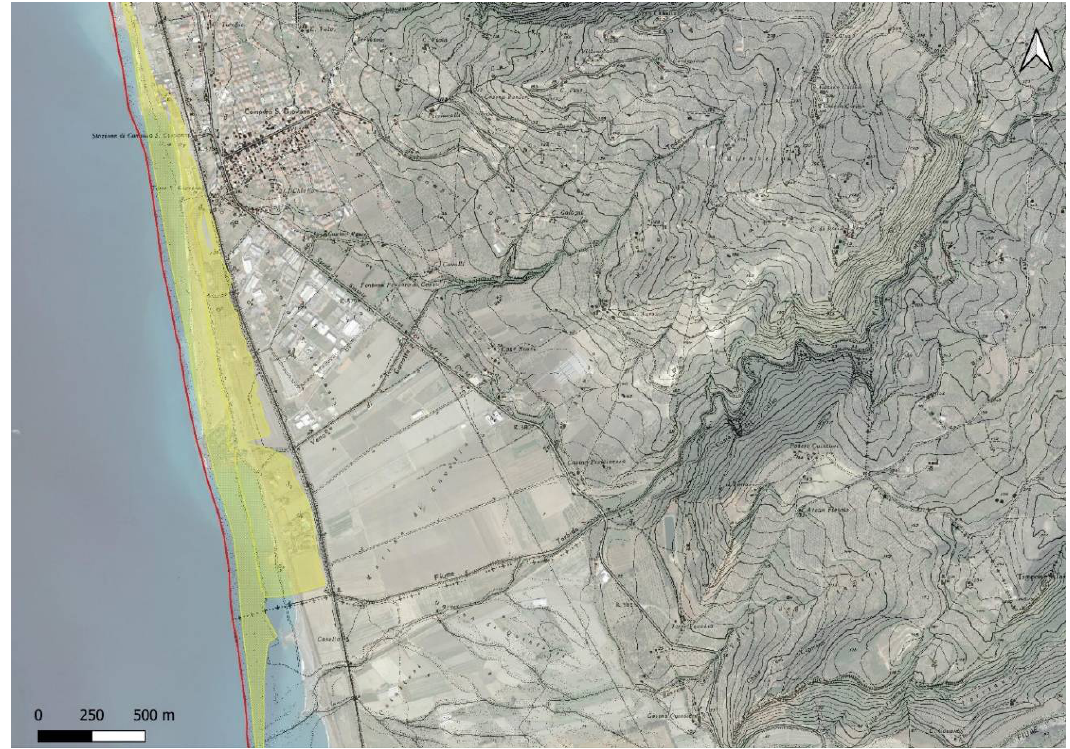
Figure 4. Amantea: overlap between CASMEZ cartography and most recent Google satellite image. Legend: red line = shoreline of 1954; yellow dotted area = dune systems of 1950s.